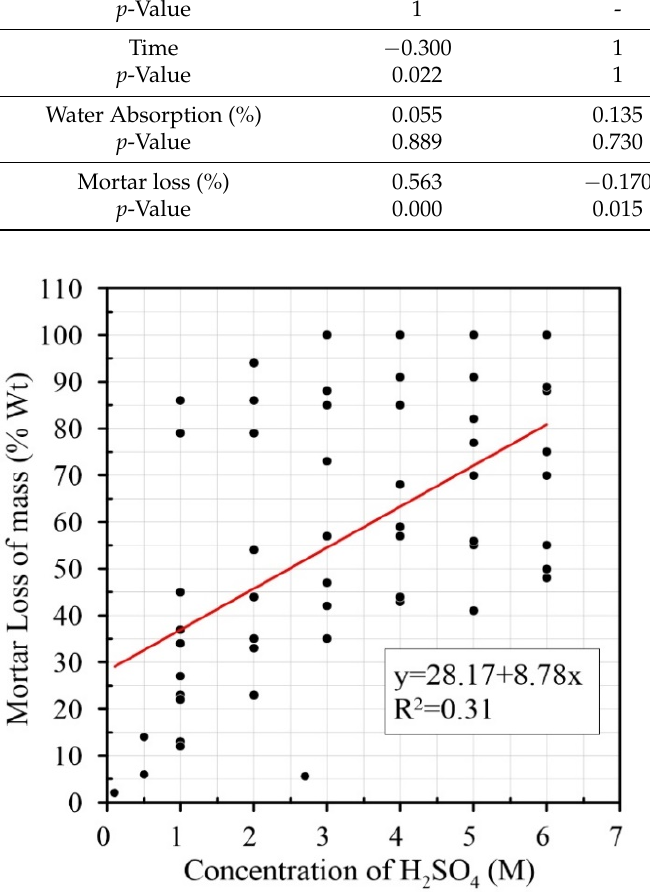
Figure 7. Relationship between concentration of H 2 SO 4 and mortar loss of mass (% Wt) [6,7,13–15].